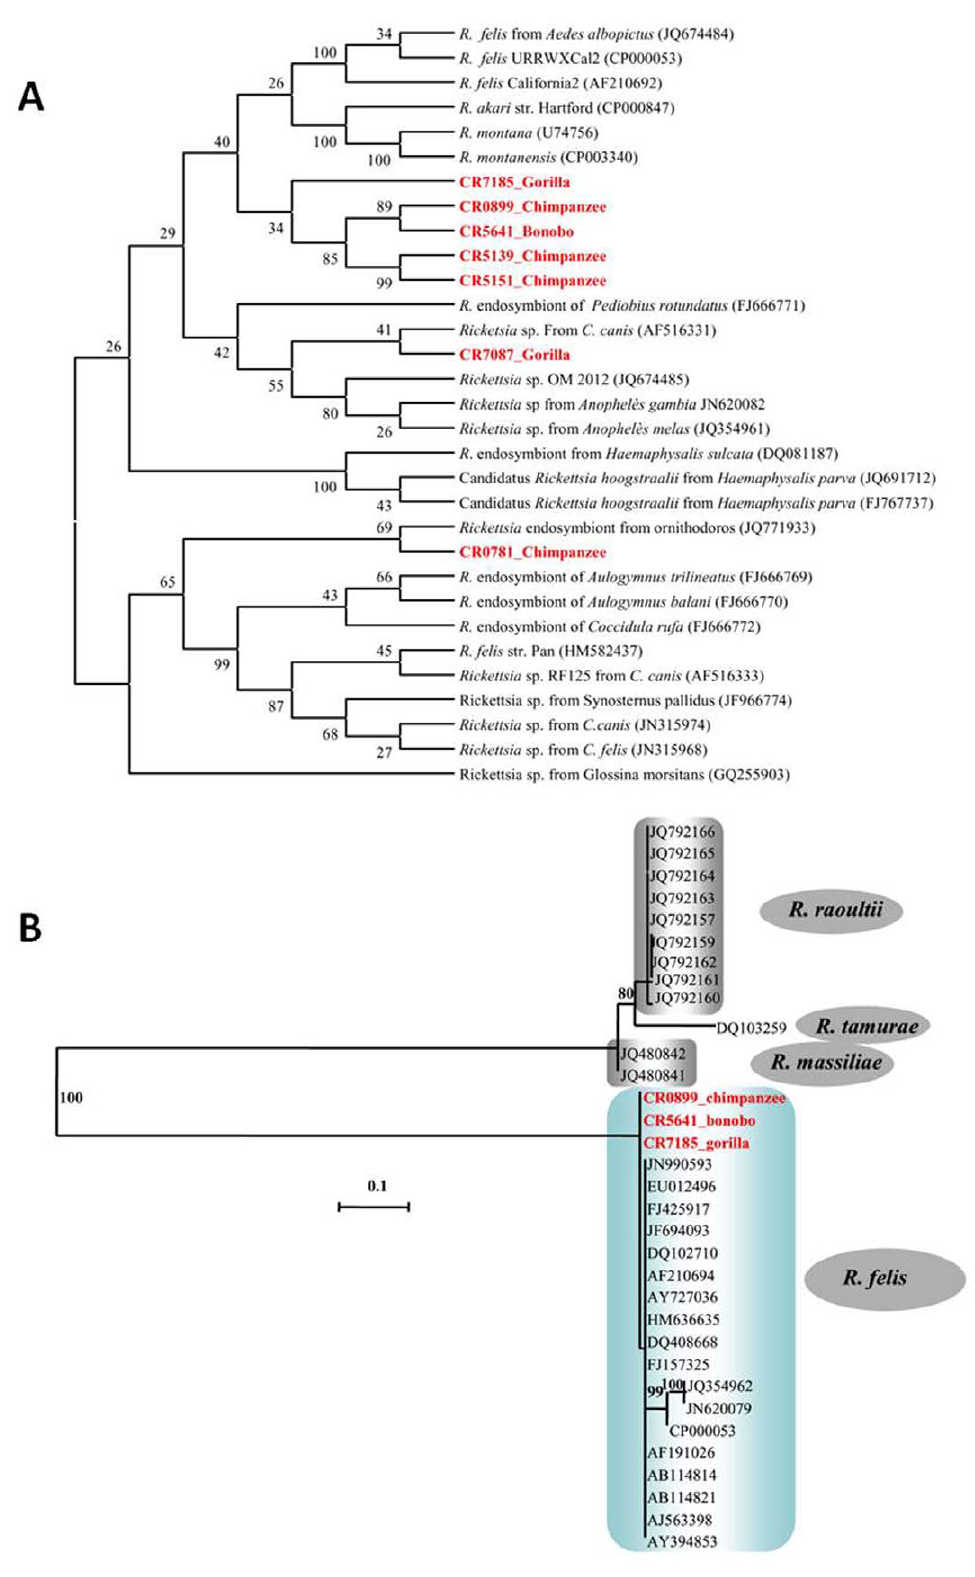
Figure 3. Maximum likelihood phylogenetic tree constructed from 30 Rickettsia spp. based on the alignment of 468 bp of the gltA gene ( Figure 3A) and 402 bp of the ompA gene from 33 Rickettsia samples ( Figure 3B), including our samples . On these trees, we see the relationship between the Rickettsia spp. that has been previously described (black) and the Rickettsia spp. detected in our study (red).